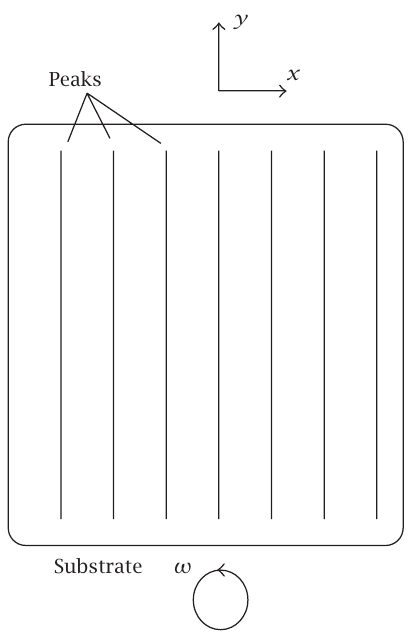
Figure 1.1 . Schematic of the coating process. The substrate to be coated has a preexisting topography, the peaks of which are shown as parallel lines. The coating solution is placed on the substrate which is then rotated in order to spread the